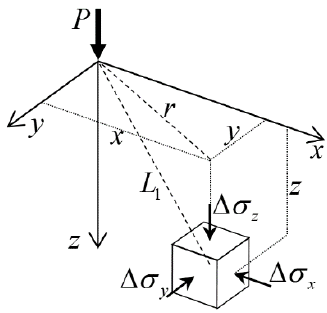
Figure 1. Stresses in an elastic medium caused by a point load acting on the surface of a semi-infinite mass.